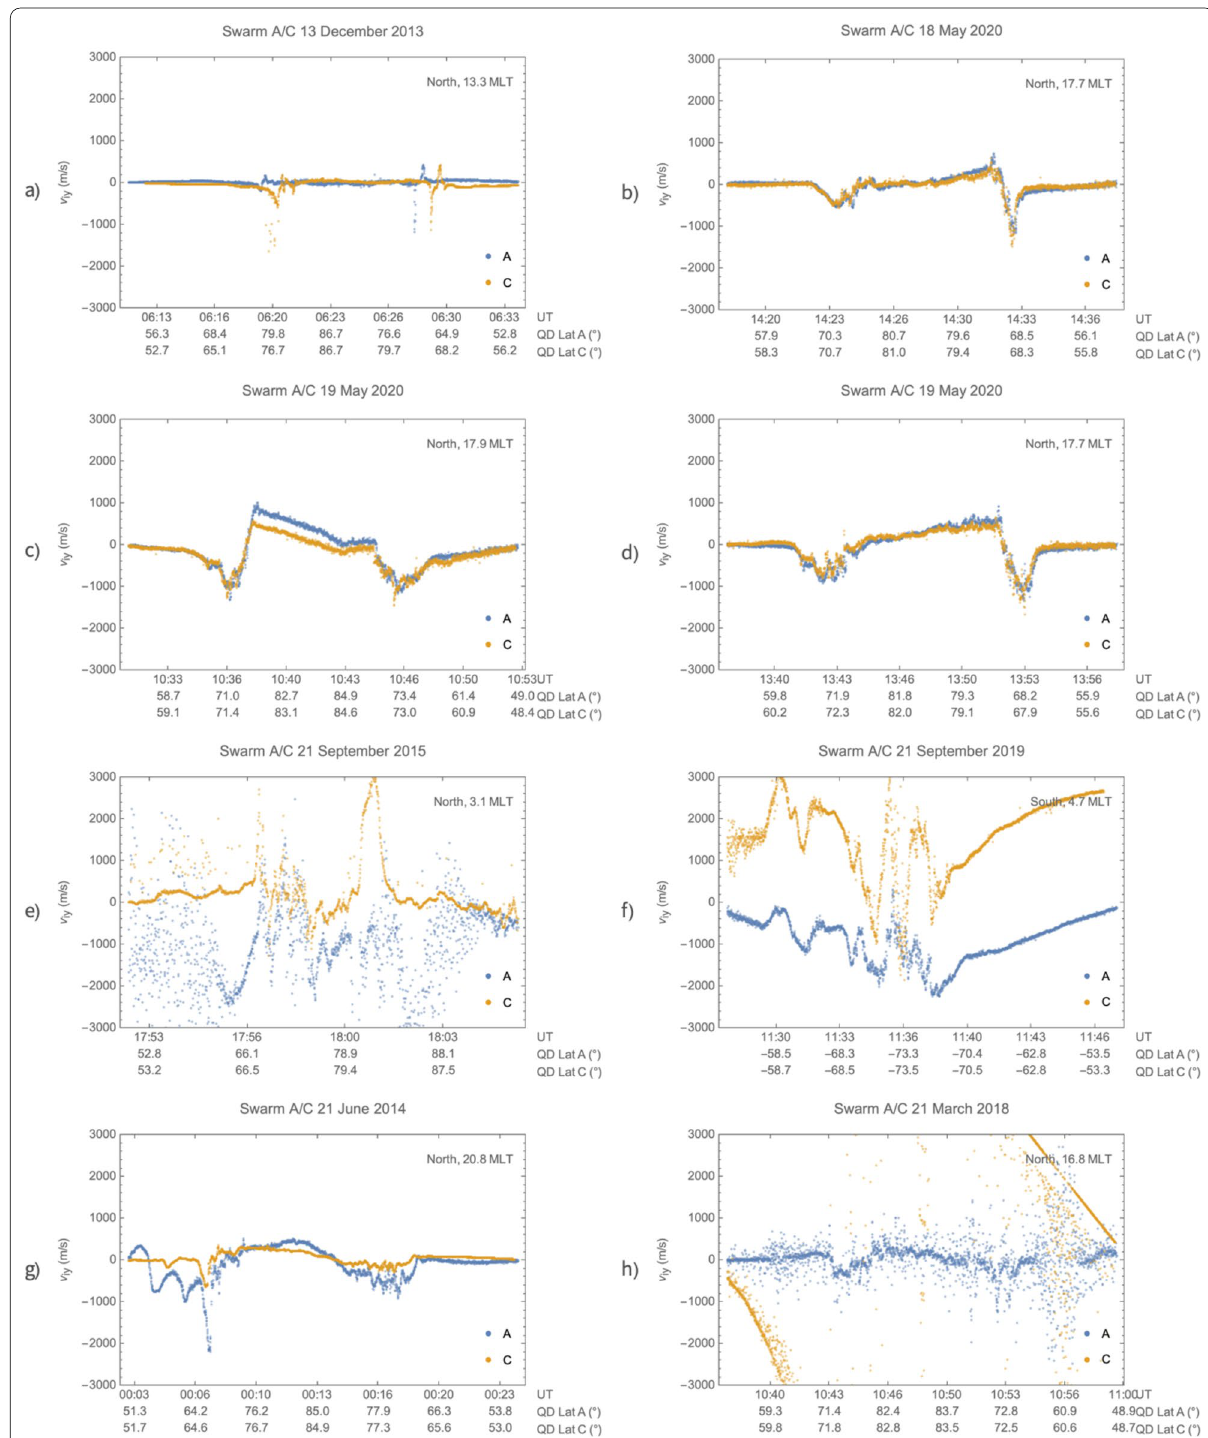
Fig. 11 Examples of realistic and unexpected cross-track horizontal ion drift from Swarm A and C at various epochs of the mission. Each series is from high latitudes, poleward of quasi-dipole latitudes of ± 50 ◦ . Cross-track horizontal ion drifts ( v iy ) from the TII cross-track ion drift dataset, version 0302, are shown for Swarm A (blue dots) and C (yellow dots). The hemisphere (north or south) and magnetic local time at the beginning of the interval are shown inset in each plot. See the “Swarm TII flight performance” section for